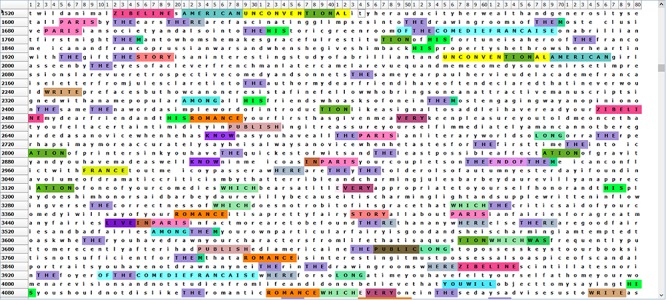
This figure shows some of the many recurrent letter T-patterns in a short text. It shows that some such patterns may not be easily given a particular meaning, as some common letter combinations often occur within words or as word endings, for example, “tion”, while the common string “the” can occur alone or as a part of a longer word.